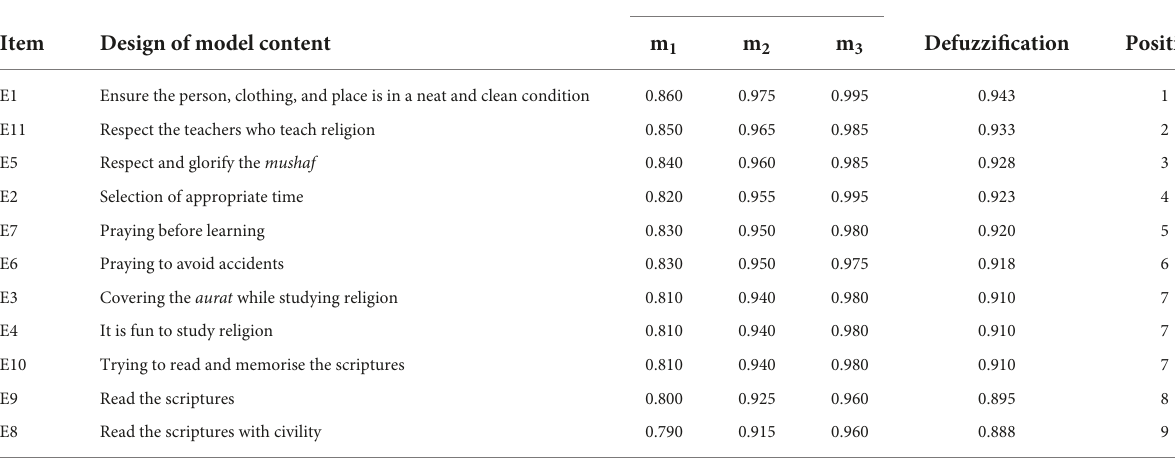
TABLE 9 Fuzzy evaluation on the construct five: Attitude learning for children with learning